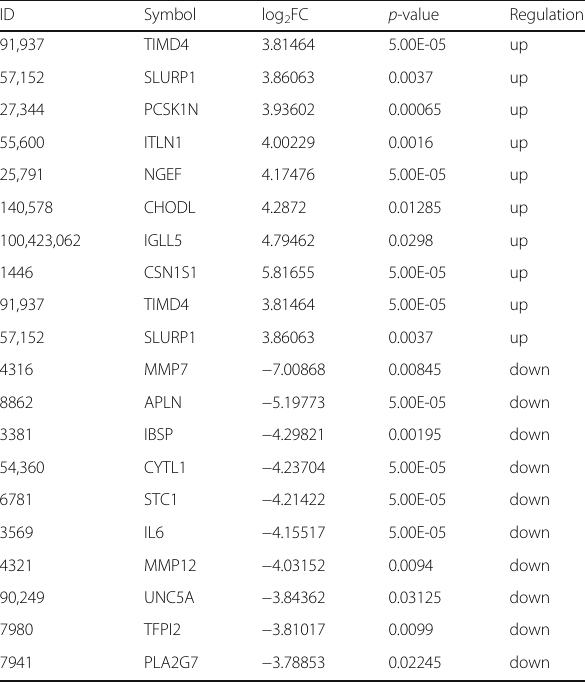
Table 2 Top 10 up- and down-regulated DEmRNAs between patients with OA and normal controls